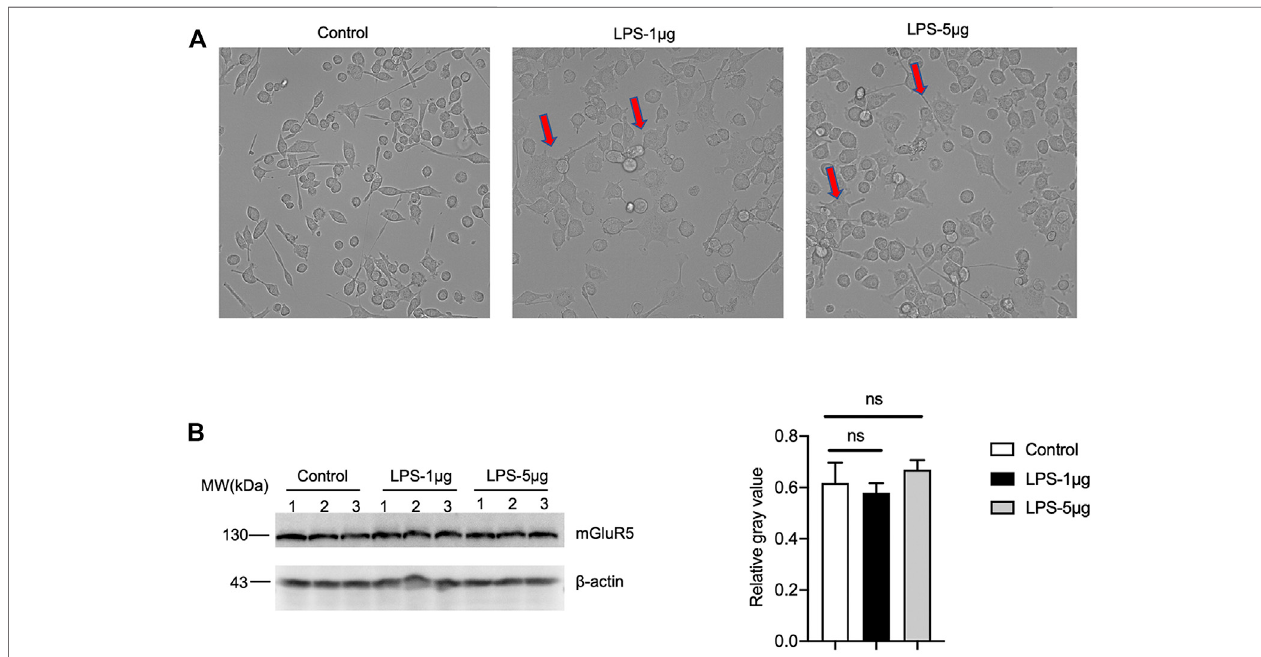
FIGURE 10 | The levels of mGluR5 in LPS-stimulated BV2 cells. (A) The morphology of BV2 cells after LPS stimulation. (B) Left: Western blot for the levels of mGluR5 in various LPS-stimulated BV2 cells. Relative molecular weights are marked on the left. (1, 2, 3) indicate the number ofreplicates. Right: Densitometric analyses of the average gray values of the signals of the mGluR5 after being equilibrated with that of β -actin.